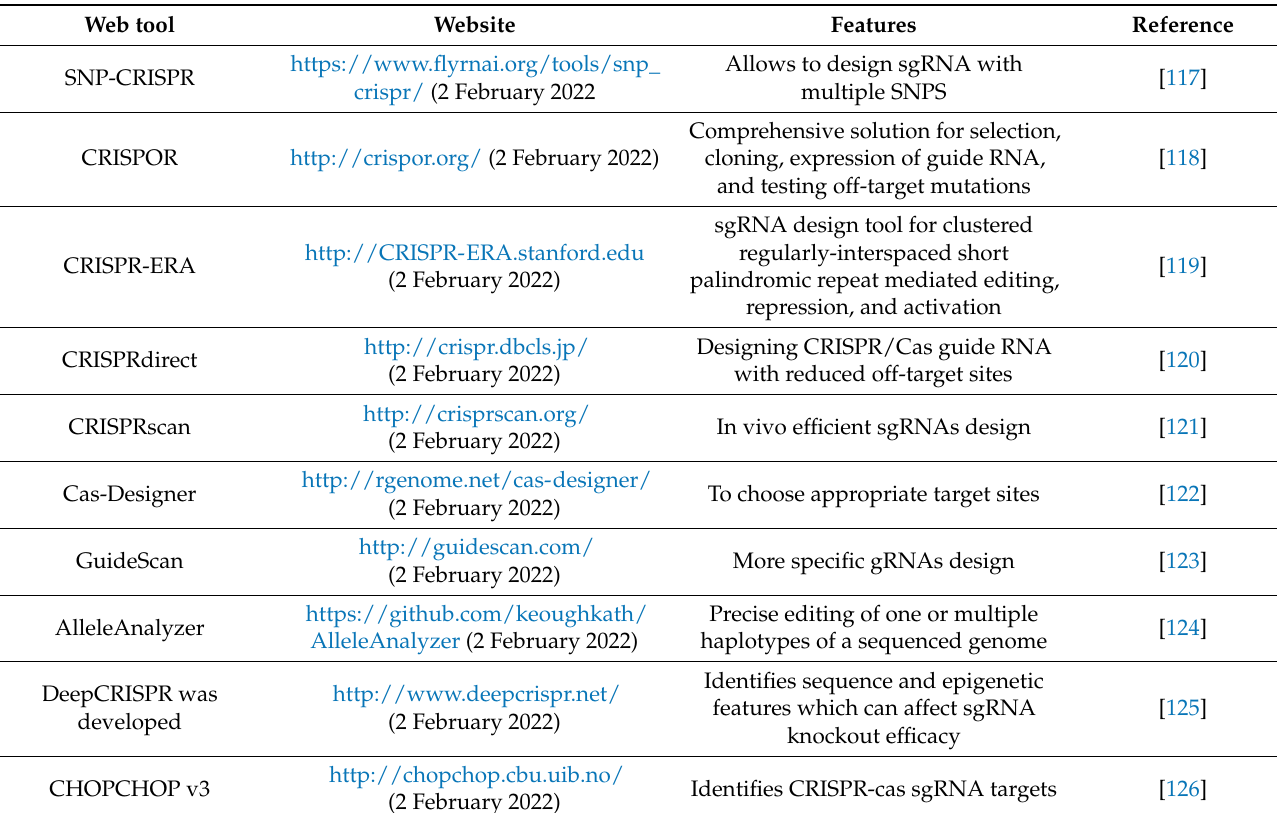
Table 2. Web-based tools used for HSPCs research